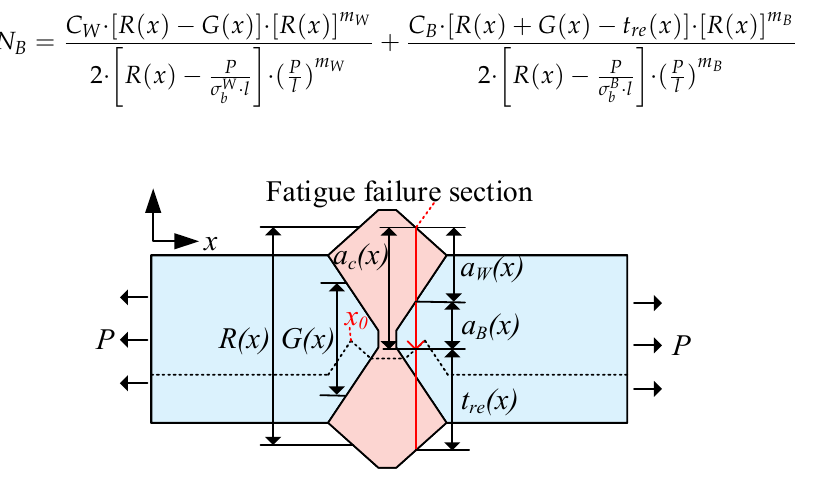
Figure 3. Double Y butt-welded joint.